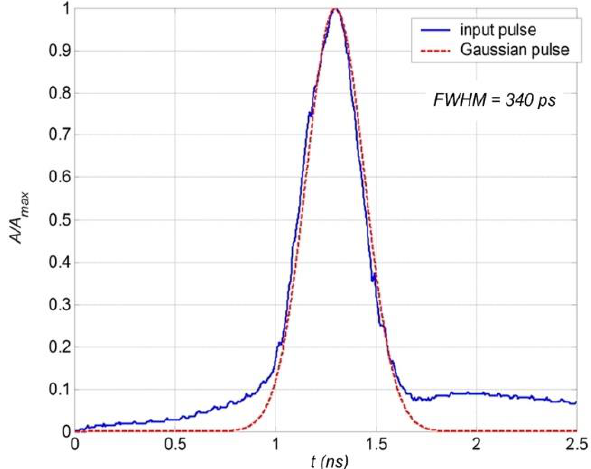
Figure 13. Reference optical pulse.